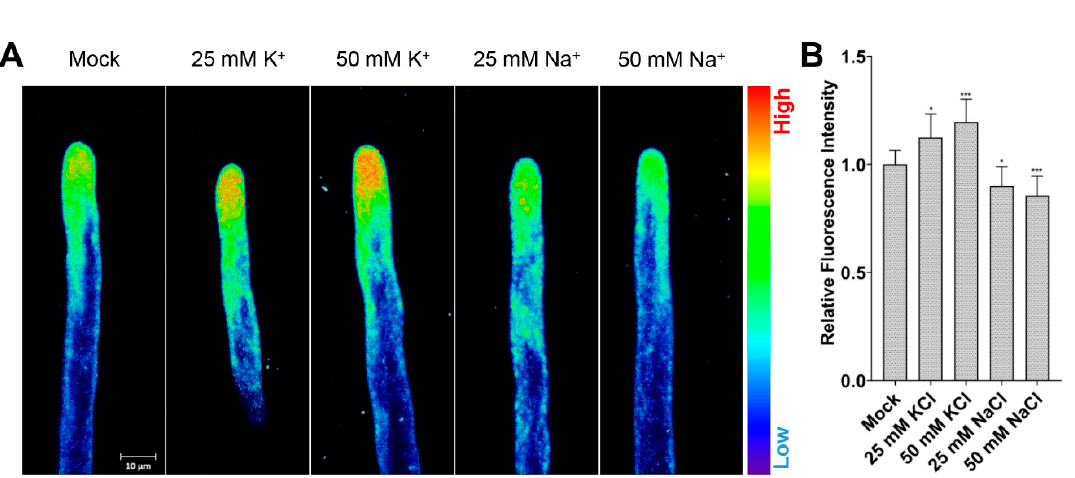
Figure 1. NK3 fluorescence intensity varies with di ff erent K + concentrations in Arabidopsis root tips: ( A ) NK3 fluorescence intensity images of 5-day-old Col-0 root hairs immersed in 1 / 2 MS medium containing 1 µ M NK3 (Mock) or 1 µ M NK3 supplemented with di ff erent concentration of KCl or NaCl (25, 50 mM) for 12 h and visualized using pseudocolor; ( B ) Quantification of the fluorescence intensity of 5-day-old Col-0 root hairs immersed in 1 / 2 MS medium containing 1 µ M NK3 (Mock) or 1 µ M NK3 supplemented with di ff erent concentrations of KCl or NaCl (25, 50 mM) for 12 h. Bars represent the average intensity (mean ± s.d.) of fourteen hairs. NK3 fluorescence was measured in approximately 30 µ m 2 regions at the apex of root hairs (Student’s t -test between Mock and treated seedlings; * p < 0.05, *** p < 0.001).